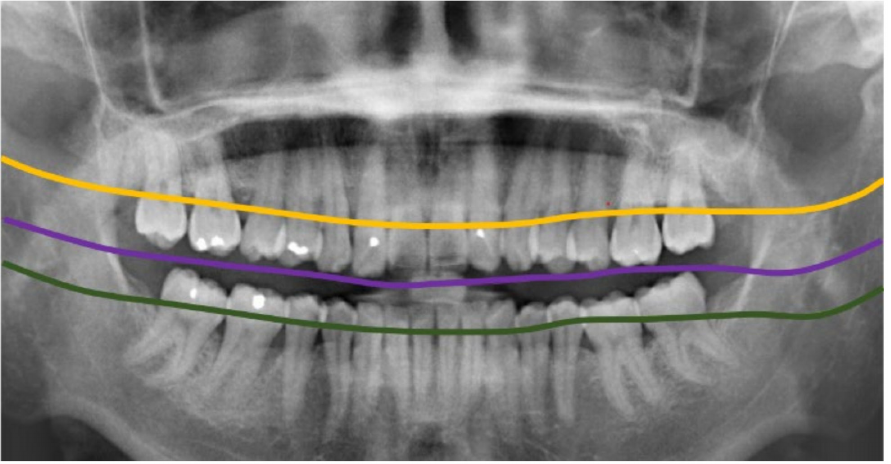
Figure 13. The curve is shifted up and down.